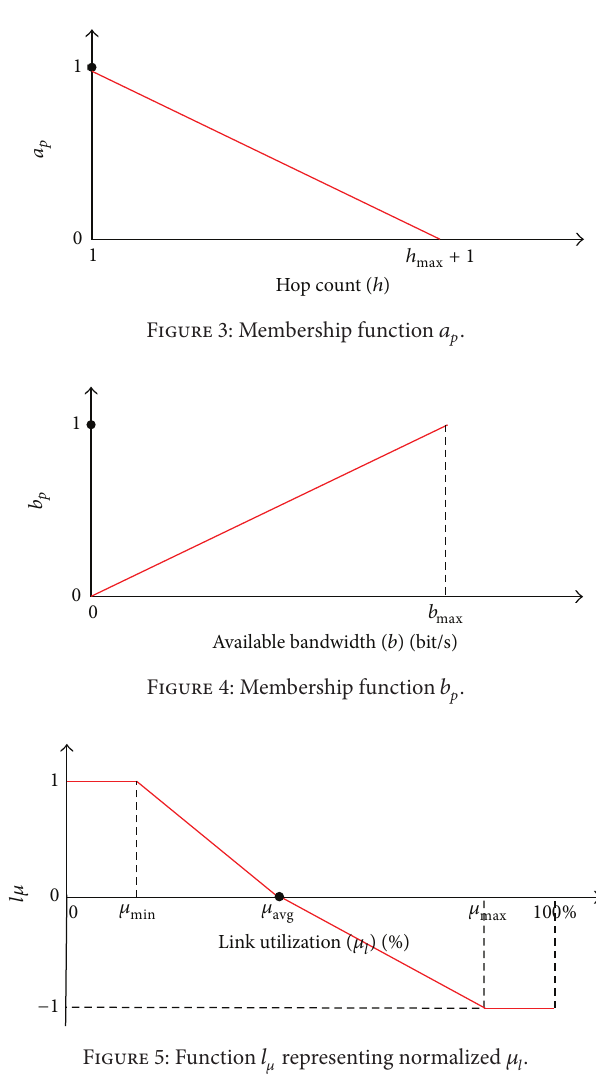
Figure 5: Function 𝑙 𝜇 representing normalized 𝜇 𝑙